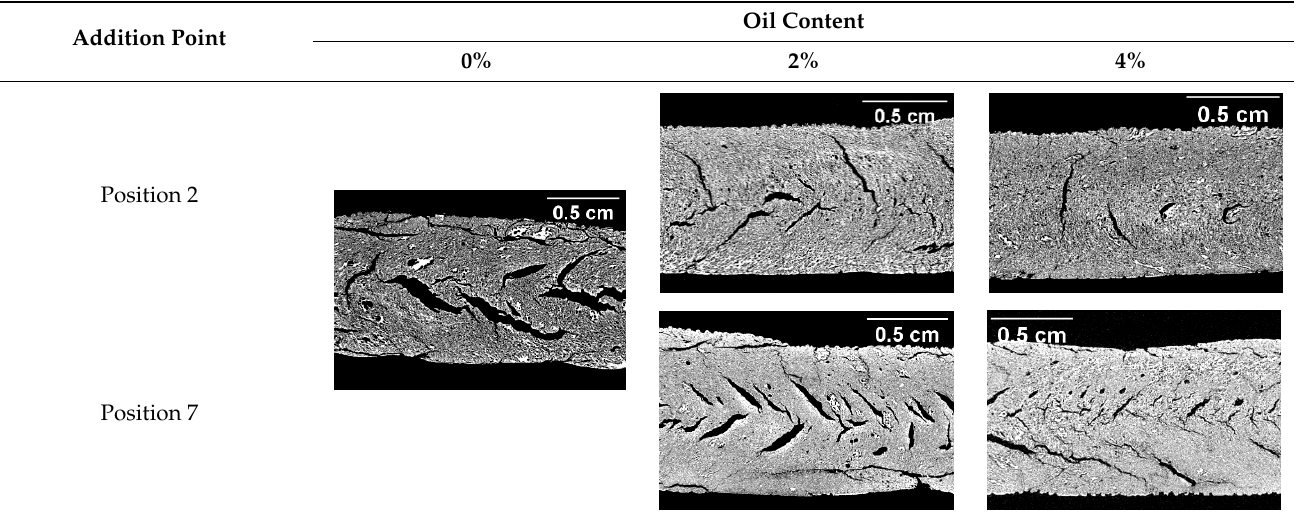
Table 1. Images of the extrudate samples teared immediately after extrusion processing. Influence of oil content on the anisotropic structure as a function of the oil addition point (position 2 and 7). The barrel temperature was 120 °C, screw speed was 400 rpm, total mass flow was 10 kg/h and water content was 51–53% for all samples. Addition Point